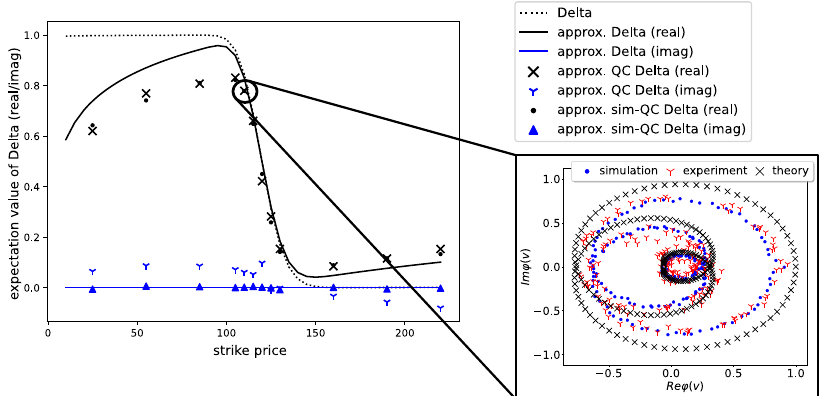
Fig. 4 Evaluation of the Delta for the European call option. Left: The Delta of an European call option is calculated for various strike prices. The underlying asset is de fi ned with μ = 0, σ = 0.02, r = 0.02, S 0 = 100, t = 1, and the time of maturity T = 10. The dotted black line is the true evaluation of the Delta. The black (blue) solid line is the real (imaginary) part of the theoretical Delta calculation obtained by a Fourier approximation with P = 100 and L = 100, which serves as the reference for the experimental validation. The black crosses (blue tri-downs) are the real (imaginary) part of the Delta calculated with the experiment on the IBM quantum computer with error mitigation applied. The black dots (blue triangles) are the simulation with noise model provided in qiskit with the same error mitigation applied. Right: This plot shows the characteristic function calculated in theory ( × ), by simulation with noise and error mitigation (dot) and the IBM quantum experiment with error mitigation (tri-down) for the example strike price of K =